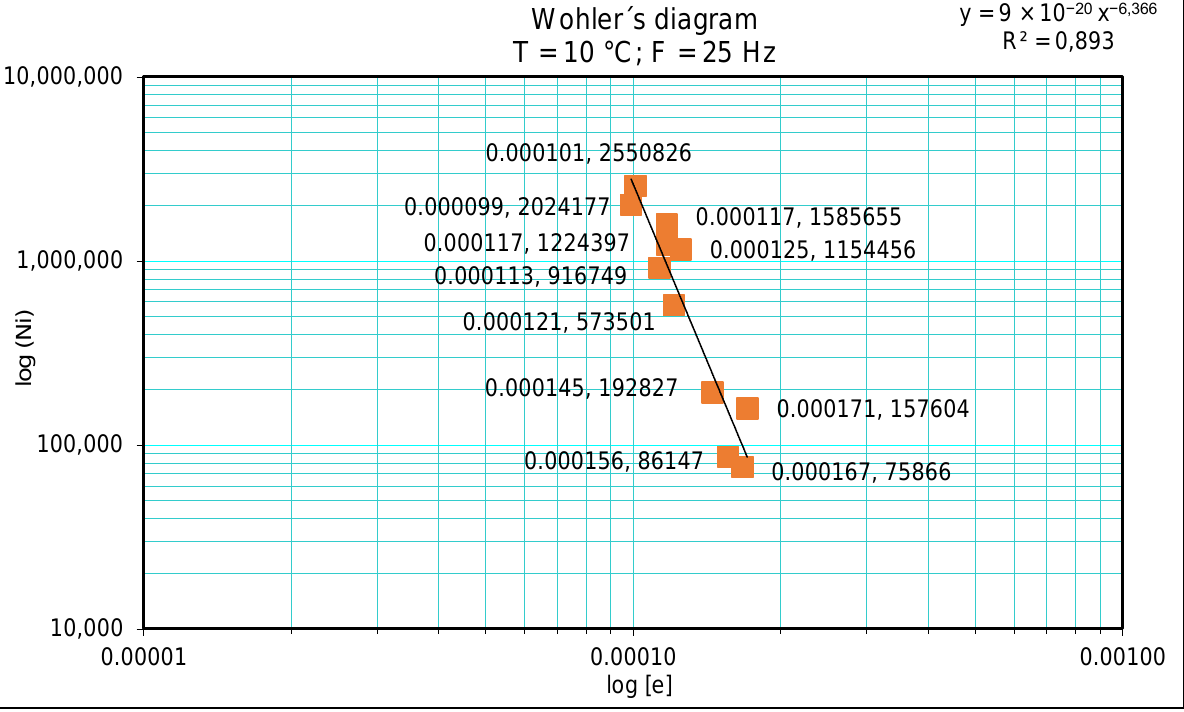
Figure 3. Wohler diagram.